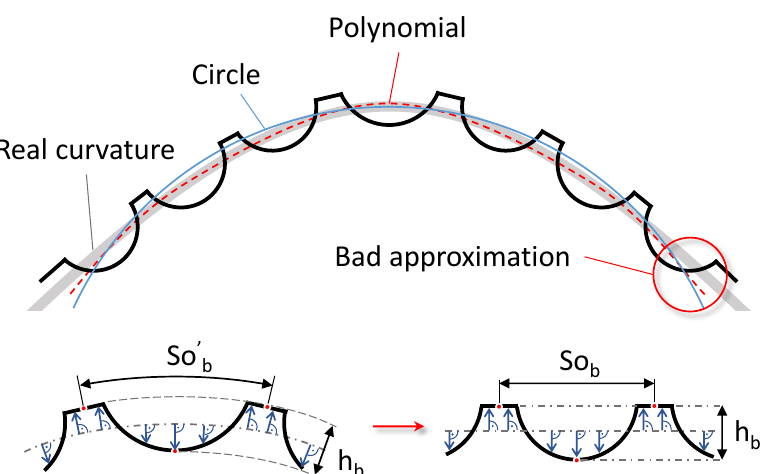
Figure 4. Bump dimension identification procedure: The shapes of the foils are not circular and are therefore generalised by polynomials. These polynomials together with their perpendicular straight lines (blue arrows) form the bases for the curved coordinate systems (bottom left). With the transformation into Cartesian coordinate systems (bottom right), the foils are virtually decurved and thus an estimation of the bump heights and distances is possible.